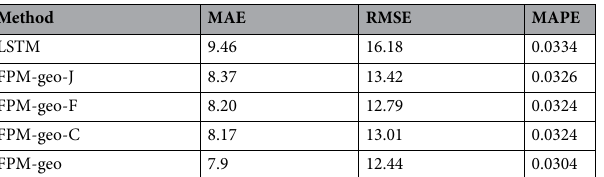
Table 2. Influence of spatial relationships on prediction. In this table, FPM-geo-J is the model without proximity. FPM-geo-F is the model without functional similarity. FPM-geo-C is the model without road network